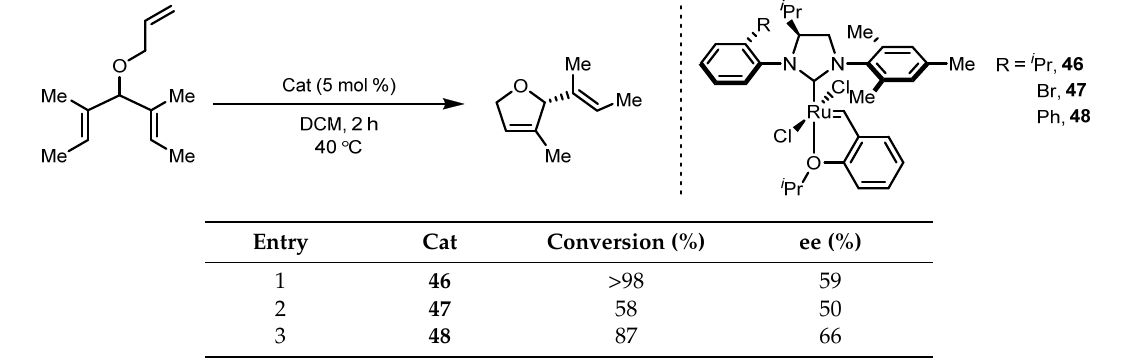
Table 13. Employment of unsymmetrical NHC ligands in ARCM by Blechert and coworkers.